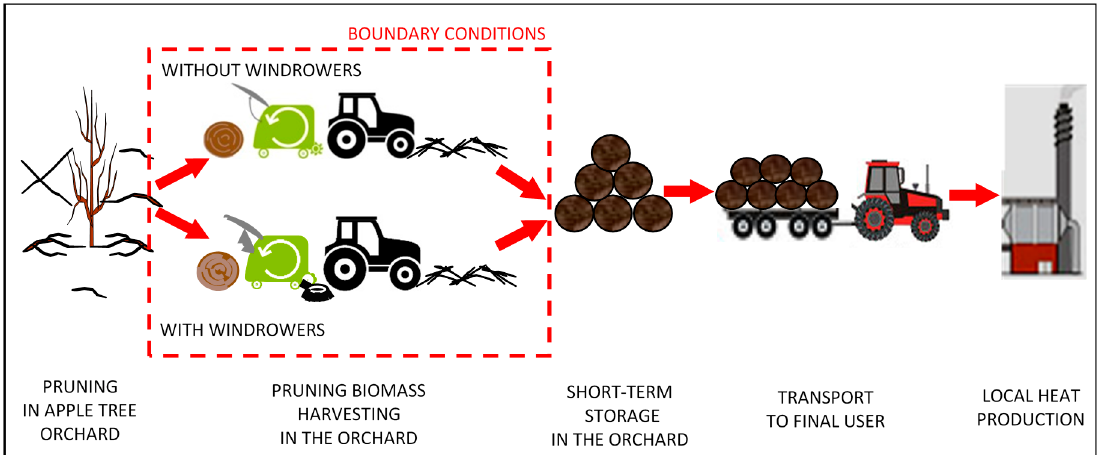
Figure 3. Boundary conditions for the energy balance analysis in this study.